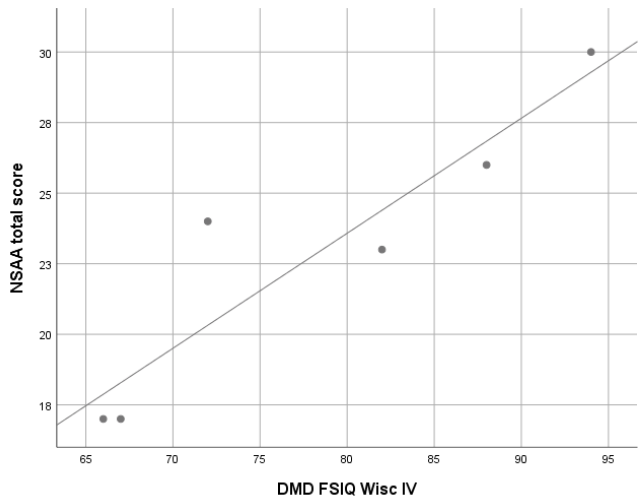
Figure 2. Correlation analysis between WISC-IV FSIQ and NSAA total scores in Duchenne muscular dystrophy (DMD) cohort. WISC-IV: Wechsler Intelligence Scale for Children, Fourth Edition; FSIQ: Full Scale IQ; NSAA: North Star Ambulatory Assessment Scale; Linear R 2 = 0.854.